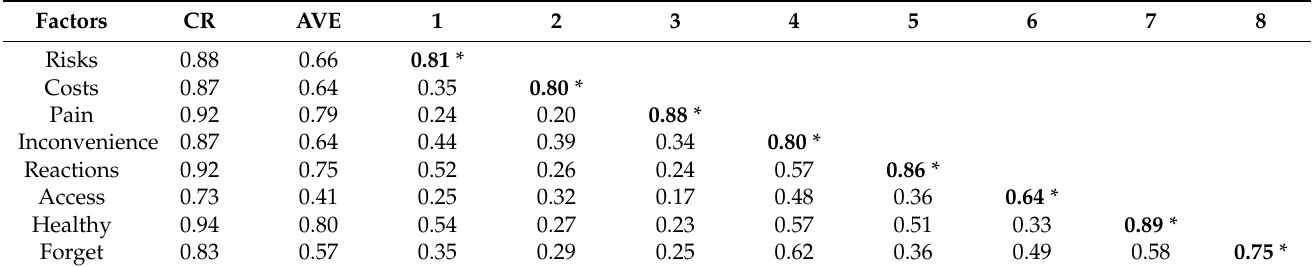
Table 7. Intercorrelations and convergent and discriminant validity.